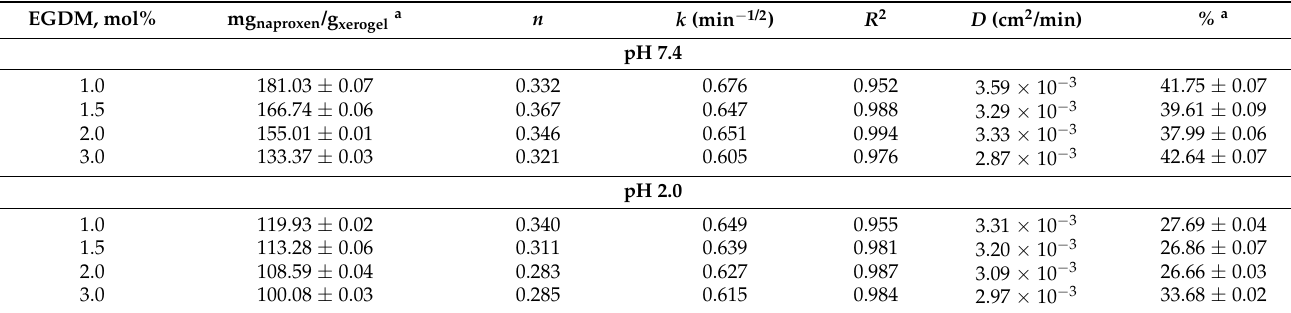
Table 7. Kinetic Parameters ( n , k and D ) of Diffusion for Released Naproxen from p( N iPAm- co -HPMet) Hydrogels at 38 ◦ C at pH 2.0 and pH 7.4. EGDM,